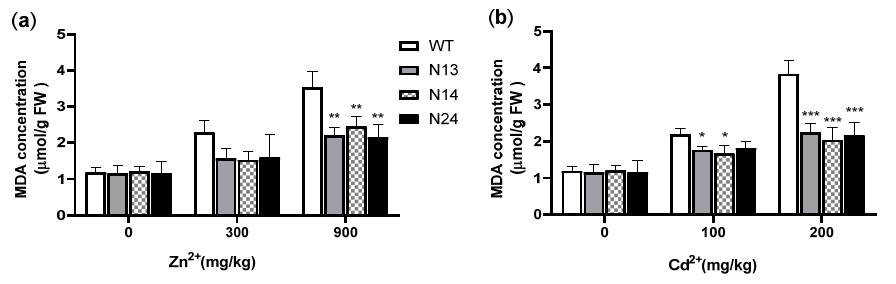
Figure 5. Comparison of MDA content under Zn 2+ or Cd 2+ stress. ( a ) MDA content of transgenic and WT tobacco under different concentrations of Zn 2+ . ( b ) MDA content of transgenic and WT tobacco under different concentrations of Cd 2+ . WT: Wild ‐ type tobacco. N13, N14, N24: Three homozygous transgenic tobacco lines (T 2 ). The 4 − week − old WT and transgenic plants were treated under Zn 2+ (0, 300, or 900 mg/kg) or Cd 2+ (0, 100, or 200 mg/kg) for 3 weeks, respectively. Asterisks indicate the significant difference between transgenic lines and WT (*, p < 0.05; **, p < 0.01 ; ***, p < 0.001).